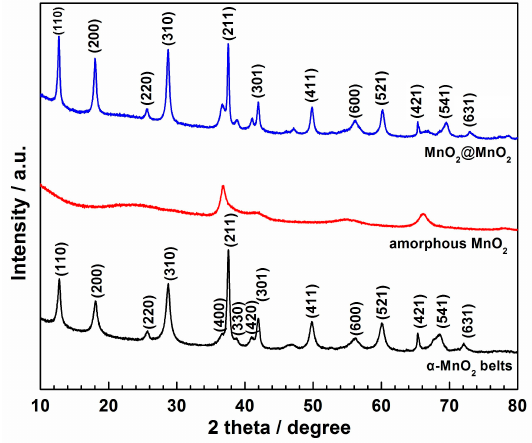
Figure 1. XRD patterns of MnO 2 @MnO 2 , α -MnO 2 and amorphous MnO 2 samples.